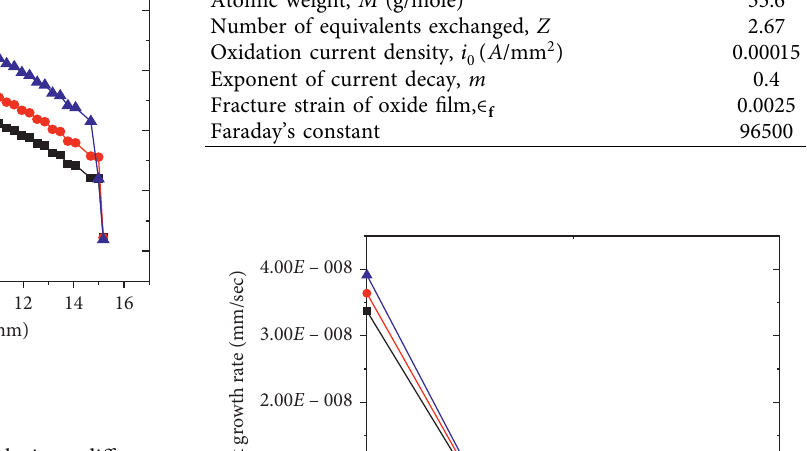
Figure 6: Normal strain vs. distance from crack tip at different loads.